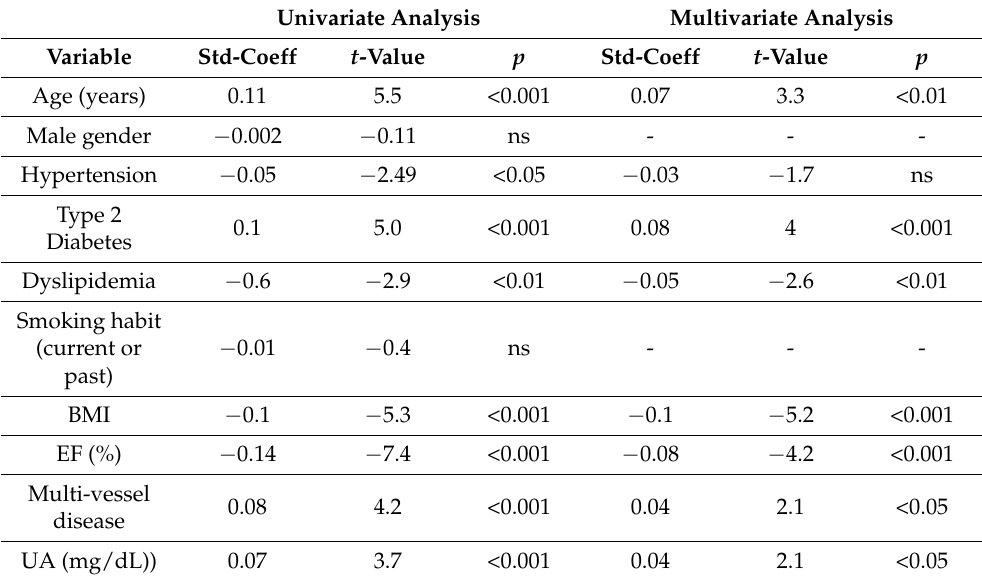
Table 3. Multiple regression between NLR and different risk